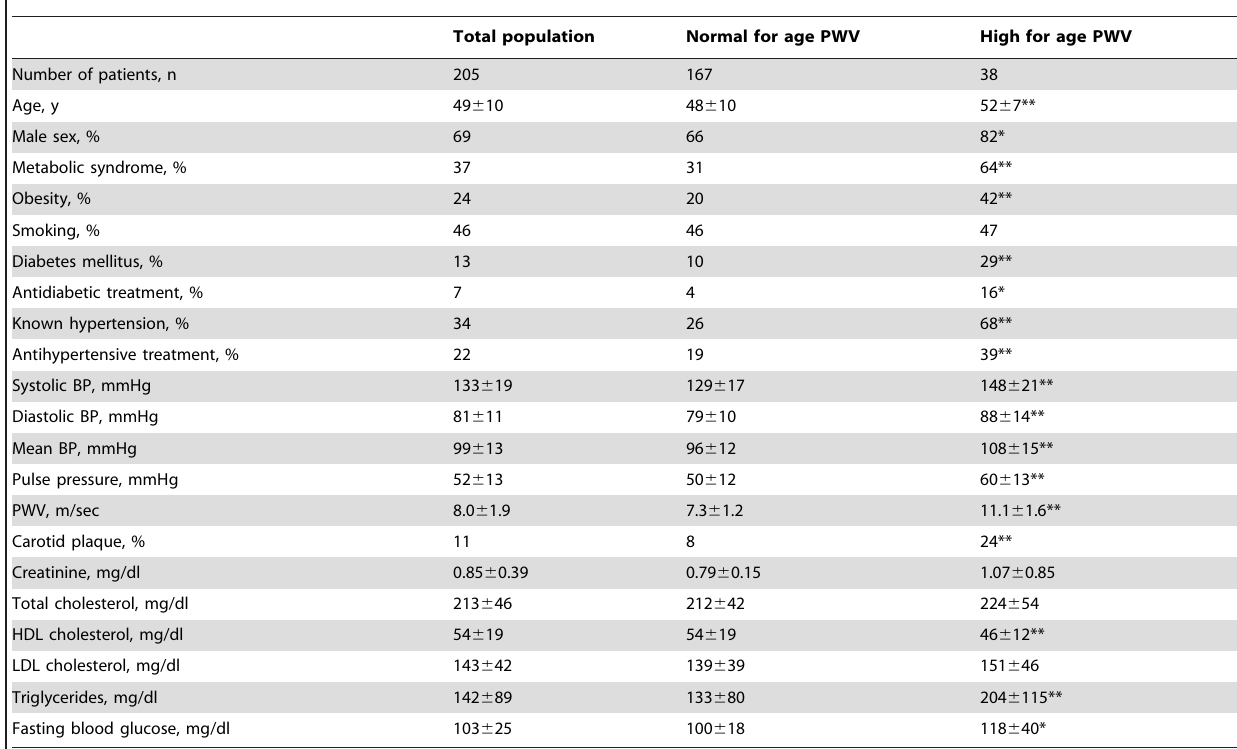
Data are mean 6 SD or percentage. *p , 0.05.